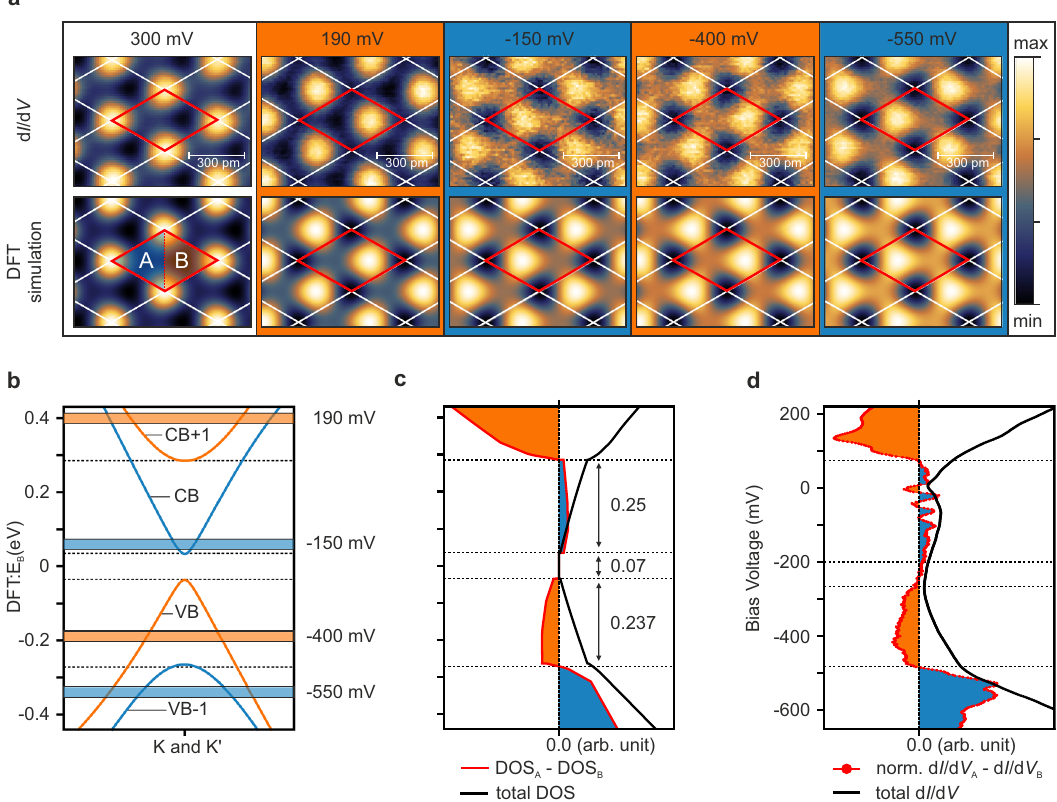
Fig. 5 Non-trivial Dirac fermion charge localization. a Spatially resolved constant height d I /d V maps taken at different energies in comparison with DFT simulations. The In atom positions are calibrated by mapping the p z orbital dominated states at 300 mV. Tuning the bias voltage to lower and eventually negative values result in distinct toggling of the LDOS maximum between the two inequivalent A/B parts of the unit cell. b Close-up of the DFT band structure and charge localization pattern at both valley momenta. The color code marks the charge maximum at the A (blue) and B (orange) sites. c DOS (black line) and A/B difference (color line) from DFT. Blue and orange areas correspond to energies with charge maxima at site A and B, respectively. d Differential conductance averaged over the entire unit cell and normalized difference of the d I /d V spectra measured at the A/B sites. The noisy behavior near E F = 0 V is attributed to the ZBA. STS data are taken at a constant tip to sample distance (see “ Methods ” section for more details). Normalized difference spectra and d I /d V maps taken at the various tip to sample distances agree qualitatively (see also Supplementary Note